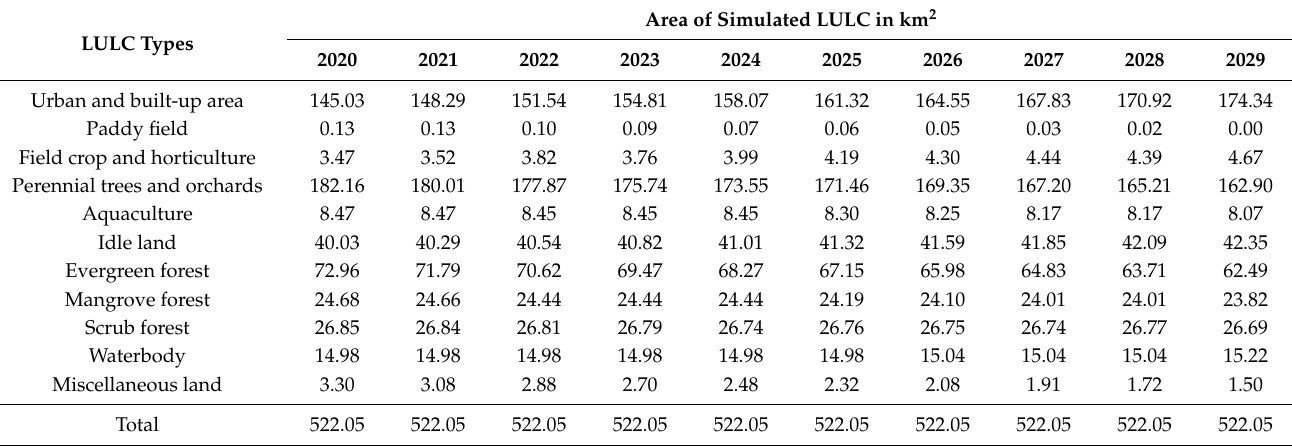
Table 11. Area of simulated LULC data between 2020 and